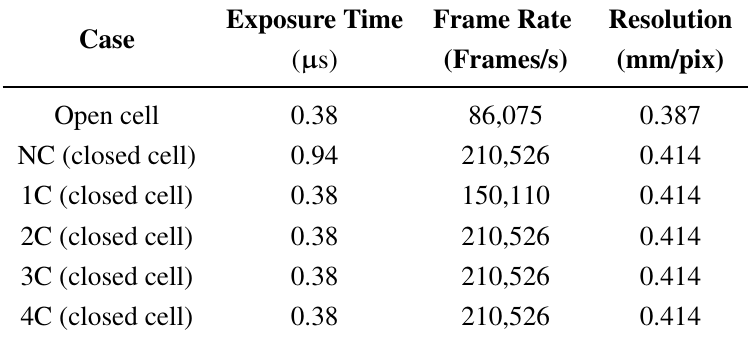
Figure 6. Logarithmic spiral description. The shock wave propagates from left to right. A Z-folded schlieren system was used to capture photographs of the shock interacting with the foam samples, further described in [40]. All photographs in this study were obtained using a Phantom V711 camera with a continuous white light source (Cree XLamp, XP-G2 LEDs, Cool White). The camera settings for the various cases are summarized in Table 1. Table 1. Camera settings. Note: the same settings were used for all open cell foam schlieren